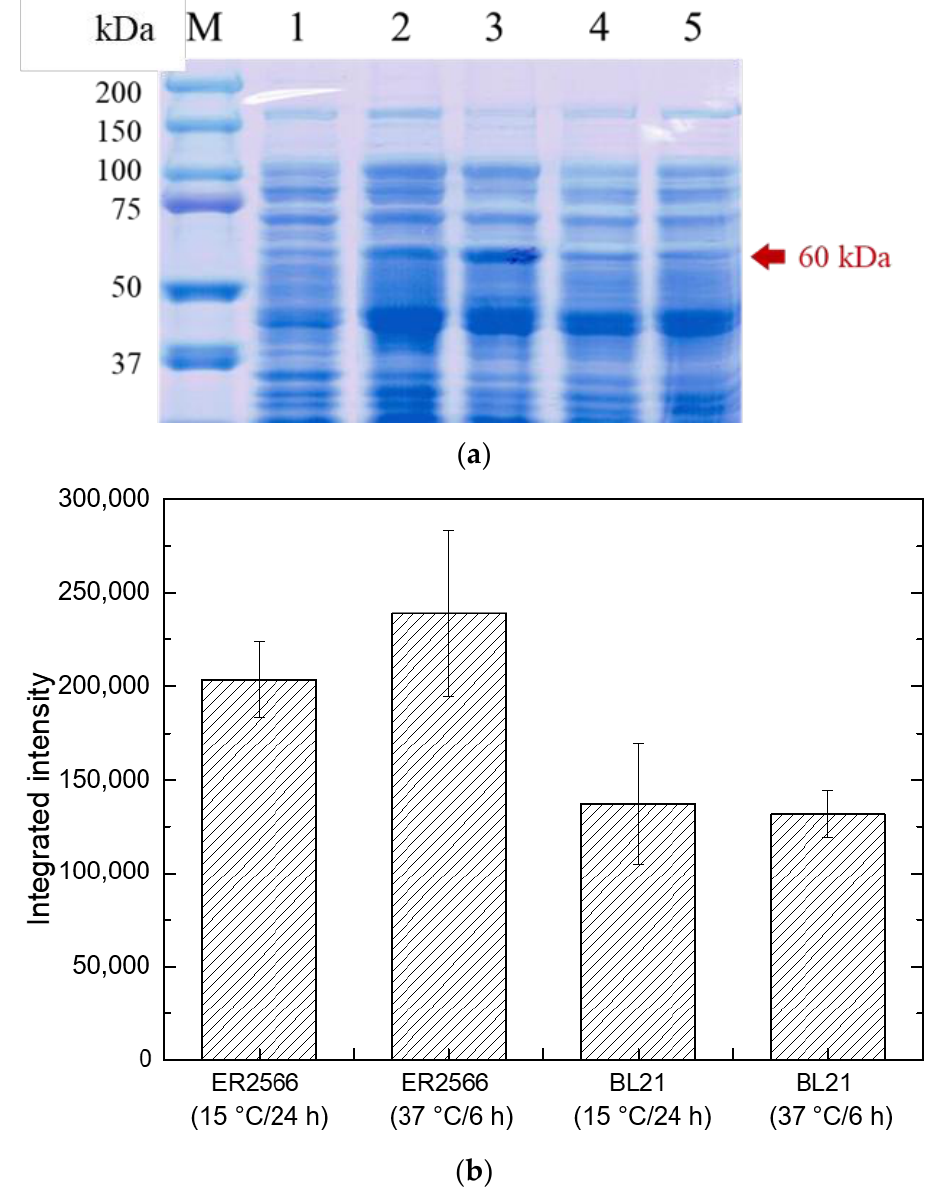
Figure 1. ( a ) SDS-PAGE electropherogram of pET21b-CelA-his with different hosts and tempera- tures. Lane M: marker (kDa); Lane 1: pET21b; Lane 2: pET21b-CelA-his/ER2566 (15 °C/24 h); Lane 3: pET21b-CelA-his/ER2566 (37 °C/6 h); Lane 4: pET21b-CelA-his/BL21 (15 °C/24 h); Lane 5: pET21b- CelA-his/BL21 (37 °C/6 h). ( b ) ImageJ analysis of protein content of pET21b-CelA-his in different hosts and temperatures.